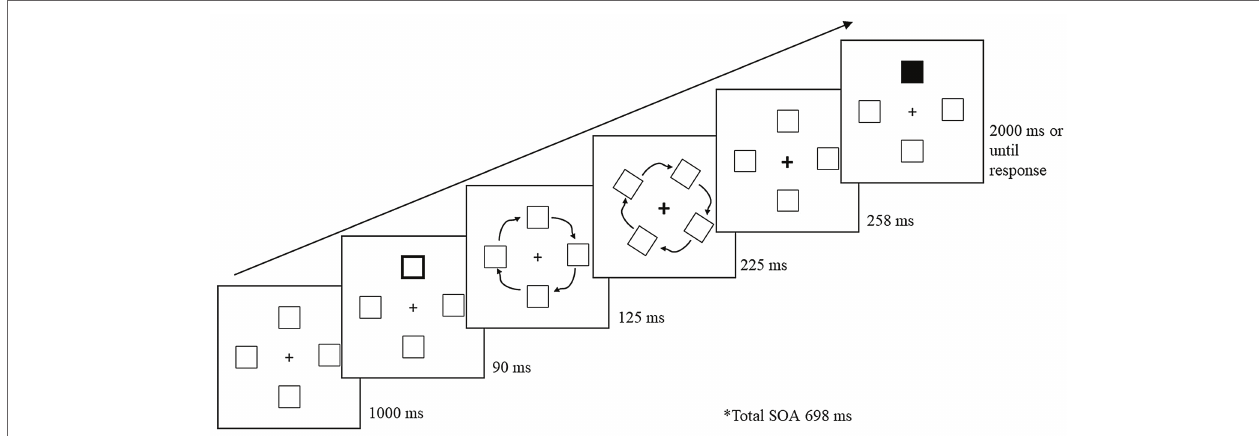
FIGURE 1 | Sample trial sequence for Experiment 1. Following a peripheral cue, the stimuli rotated 90 ° during which the central fixation cross was cued to draw attention back to the center. Following a 698 ms cue-to-target stimulus onset asynchrony (SOA), the target (a black box) was presented at one of the four boxes. The present example is a cued-object